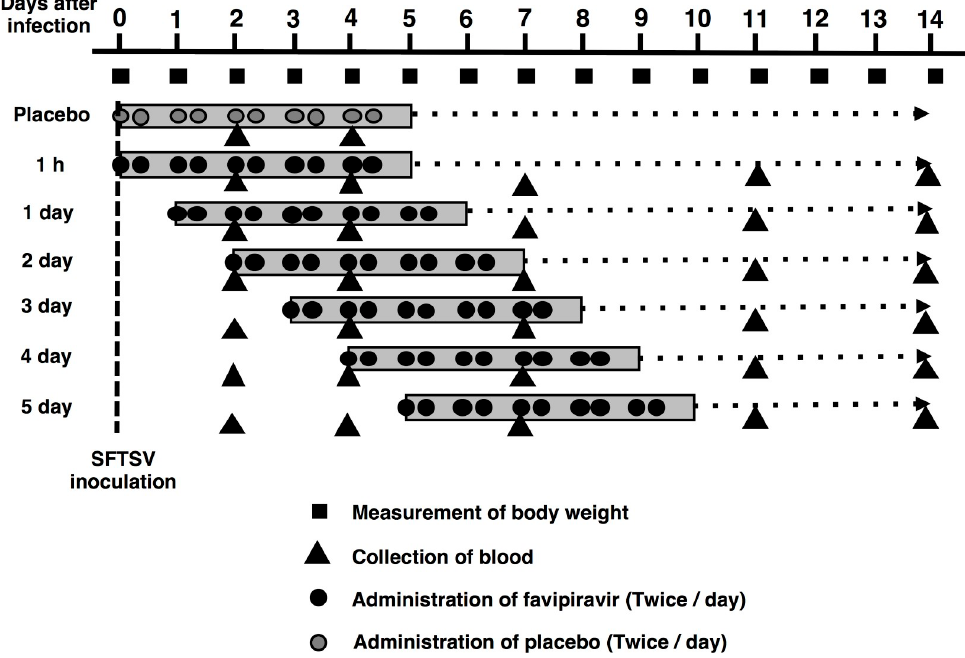
Fig 1. Schematic experimental design. Six mice in each group were administered favipiravir at either 120 mg/kg/day or 200 mg/kg/day starting at 1 h or 1, 2, 3, 4, or 5 days post infection and continued for 5 consecutive days. Placebo control mice were treated with an equal volume of 0.5% (w/v) methylcellulose solution administered at 1 h post infection and continued for 5 consecutive days.